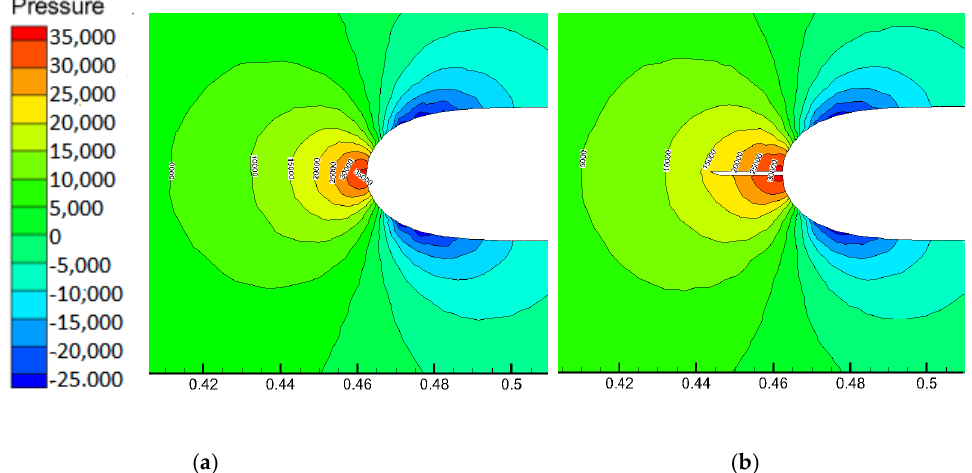
Figure 8. The pressure contour at Plane A of the two models. ( a ) The original model; ( b ) The model with the leading-edge serrations.